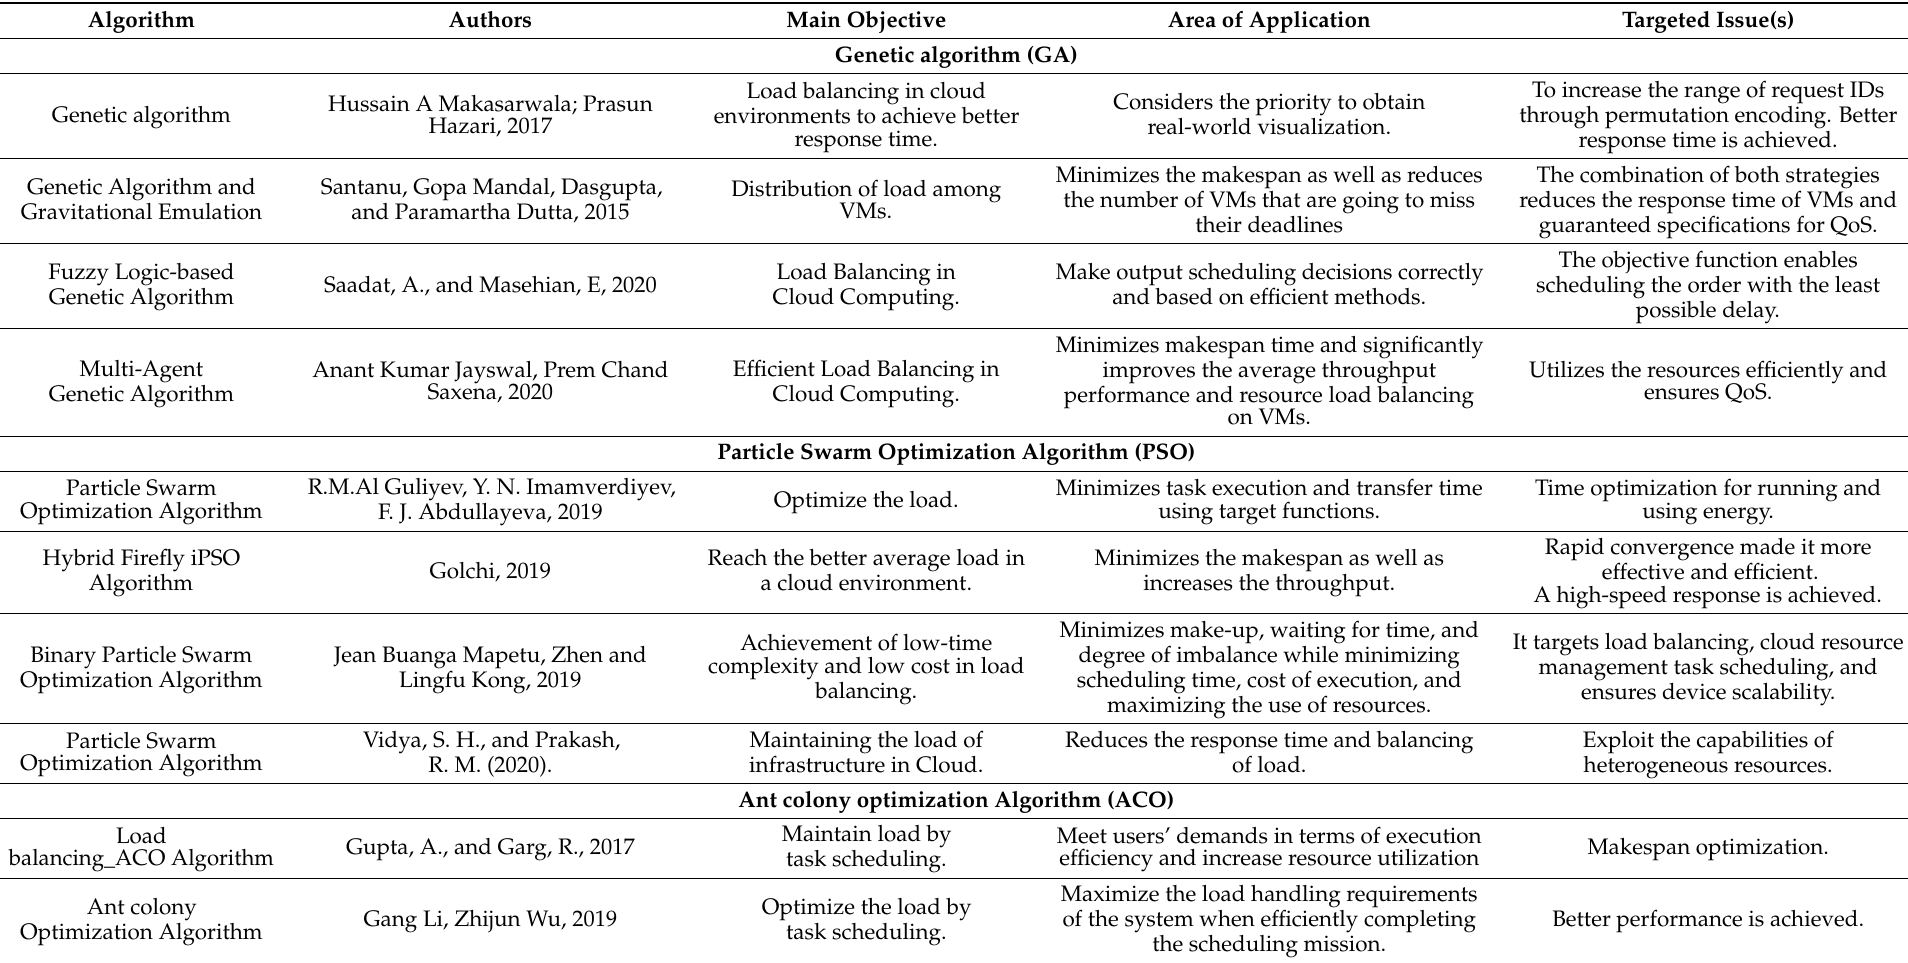
Table 6. Summary of the SI based load balancing algorithms for cloud